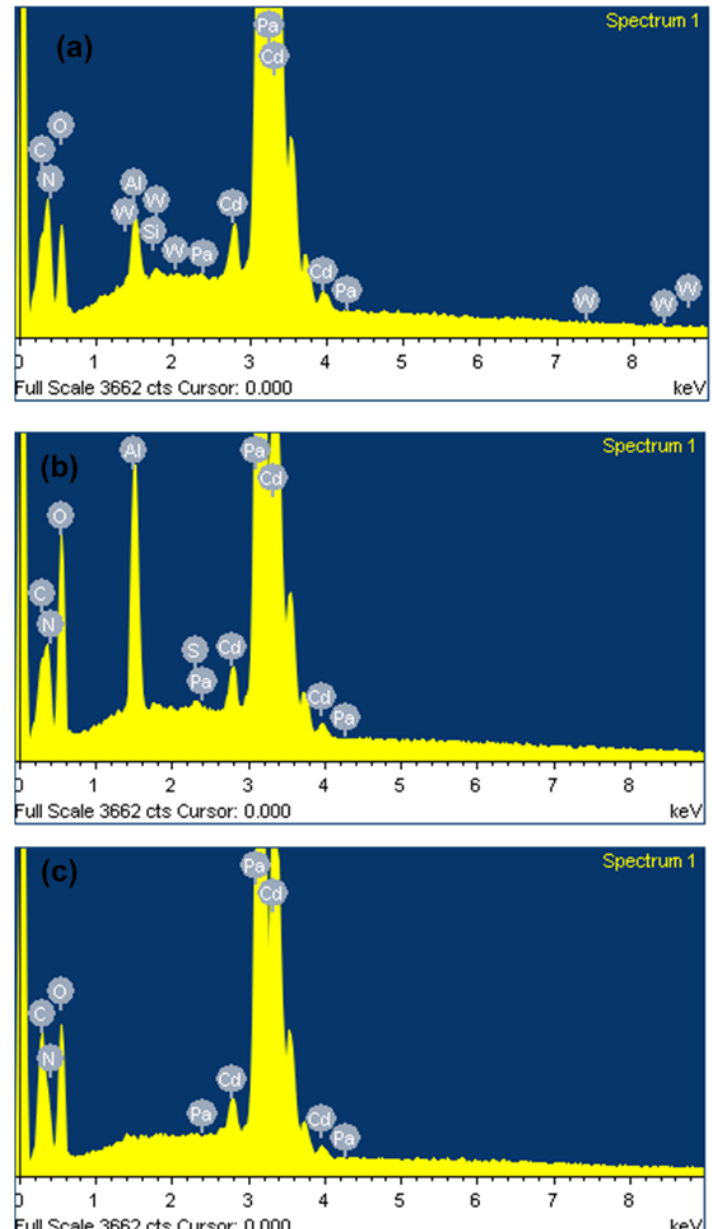
Figure 9. Original spatial elemental map of ( a ) pristine and irradiated Cd targets for 500 pulses in ( b ) DI water and ( c ) ethanol ambient.